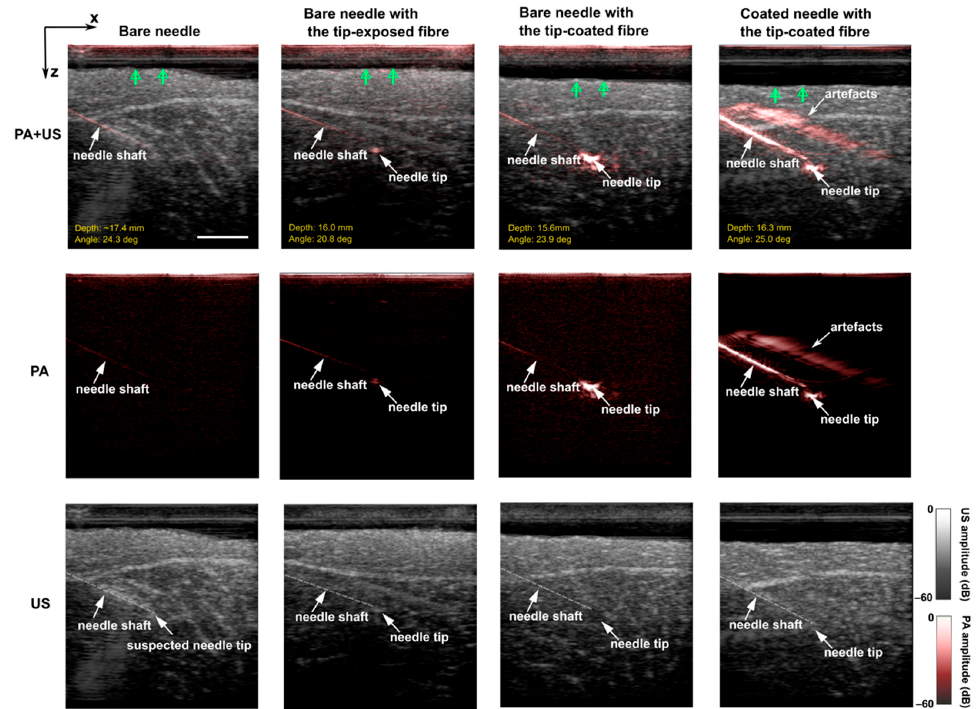
Figure 5. Overlaid Photoacoustic (PA) and Ultrasound (US) images, PA images, and US images acquired during in-plane needle insertions into a pork joint tissue ex-vivo with a bare needle, a bare needle with a tip-exposed fibre, a bare needle with a tip-coated fibre, and a coated needle with a tip-coated fibre. Insertion depth was defined as the shortest distance from the suspected needle tip to the skin surface (denoted by green arrows). Insertion angles were measured from the positive x-axis going clockwise. In US images, needles including the tip were marked (translucent white dashed lines) according to corresponding PA images. Images were obtained from real-time reconstructions and displayed on a logarithmic scale. All the images have the same scale bar of 1 cm.